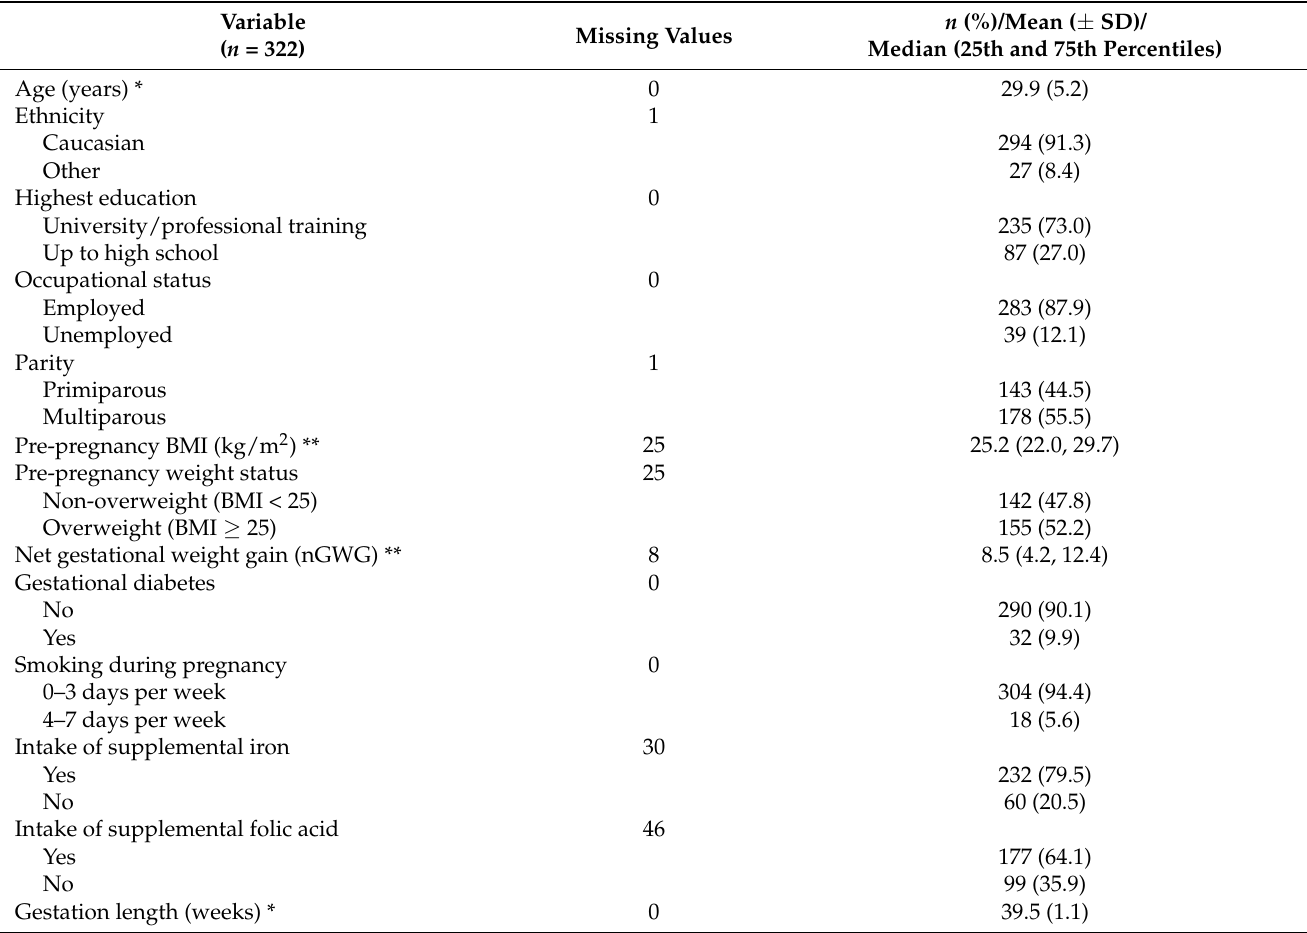
Table 1. Baseline characteristics of mothers.